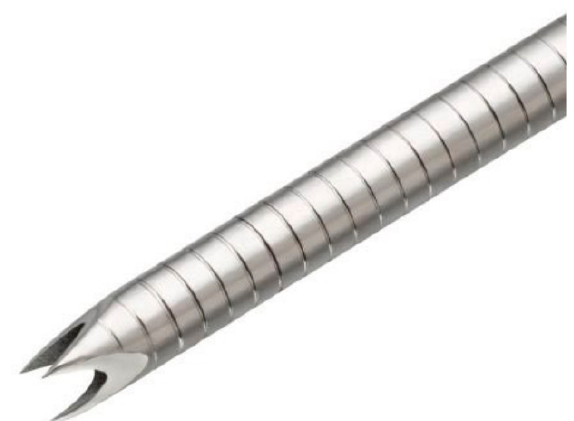
Figure 1. A Franseen needle, which has three points and heels on the tip. © 2022 Boston Scientific Corporation. All rights reserved. Reprinted with permission from Ref. [https://www.bostonscien- tific.com/pt-BR/produtos/agulhas/acquire.html]. 2022, Boston Scientific